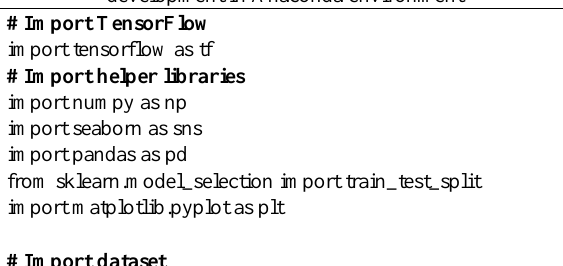
Table 2 Step D, Python TF classifier programming and development in Anaconda environment